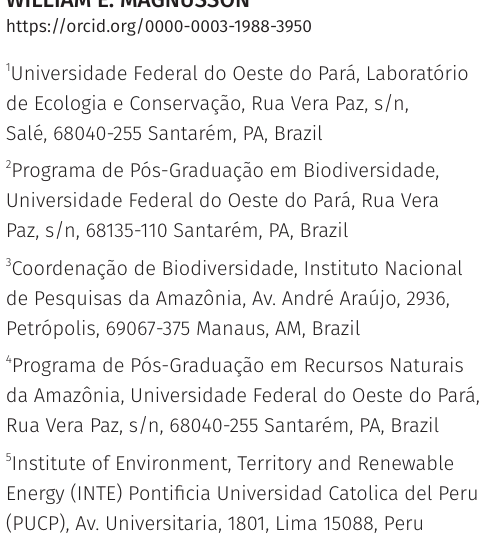
Figure S1. The POPA PELD (Box 1) accommodates plots from the Alter do Chão LTER (black box above) and the RAPELD plots located in the Tapajós National Forest. Plots are distributed along a gradient of soils, vegetation, and human disturbance. Table SI. Articles published, dissertations and theses concluded, species list, plot status and online